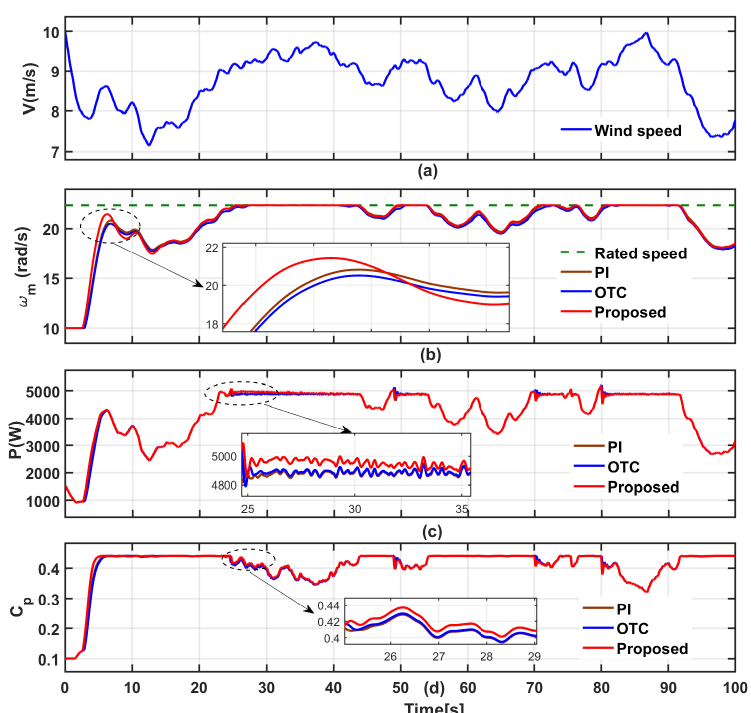
Figure 11. Simulation results for PMVG-based WECS under the case II with region II and region III